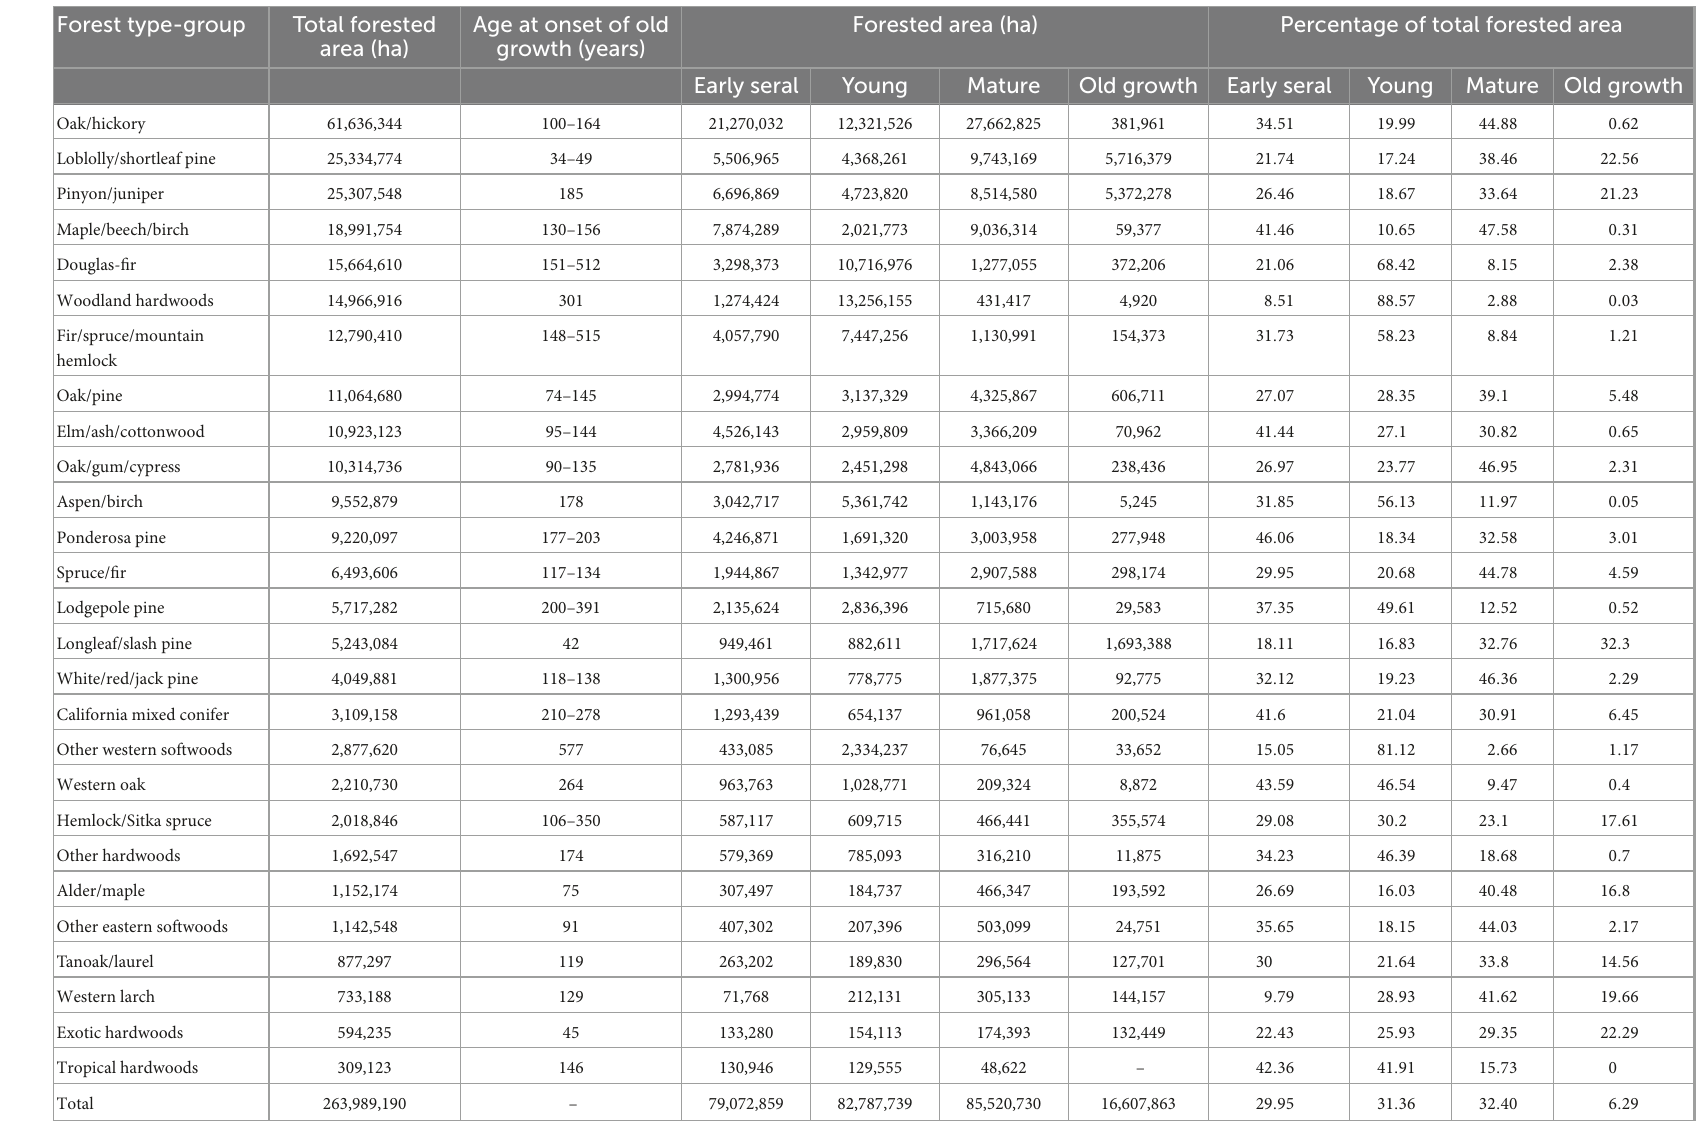
TABLE 3 Estimates of total forest area, range of age at onset of old growth, forested area by stand development phase, and proportion of total forest area in each stand development phase across forest